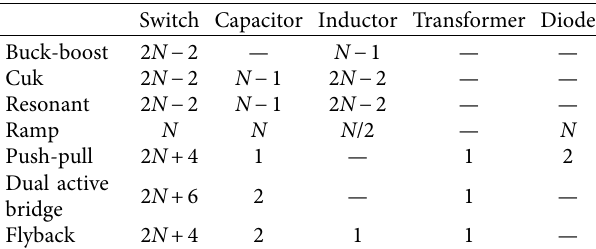
Table 8: Components required for designing DC-DC